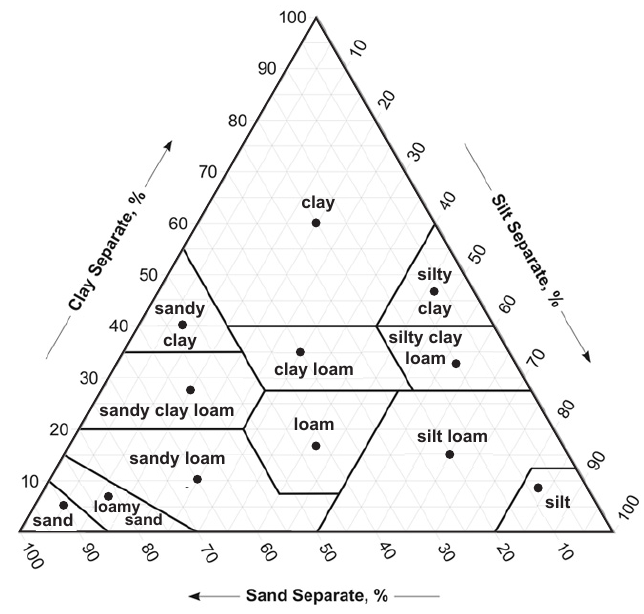
Figure 2. Soil triangle showing the twelve soil classes of the Unified Soil Classification System and their respective proportions of sand, silt, and clay. Points indicate the specific compositions used to